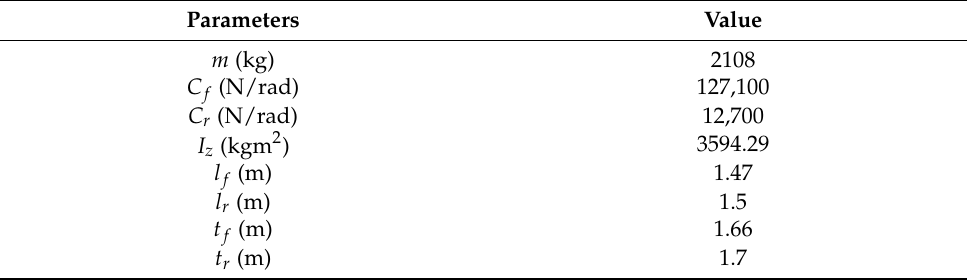
Table 1. Vehicle model parameters.